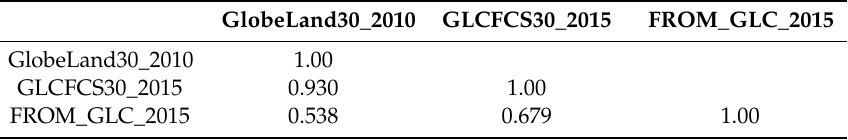
Table 3. Area correlation coe ffi cients between di ff erent